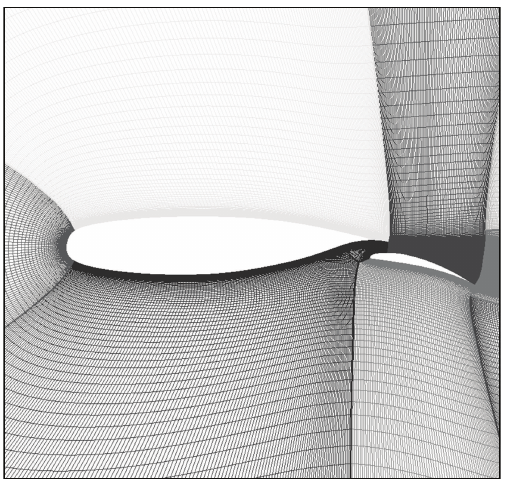
Figure 2: NLR-7301 two elements high lift airfoil and its typical grid topology from ECARP and FLOWNET (2.6% flap-gap).